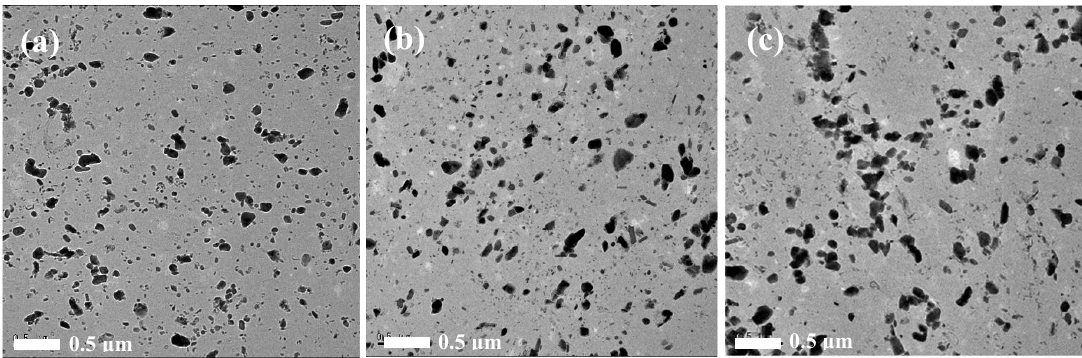
Figure 3. Transmission electron microscopy (TEM) micrographs showing the variation in precipitates morphology of 600 s hold time; ( a ) 0.1 N f , ( b ) 0.2 N f , and ( c ) 1 N f .